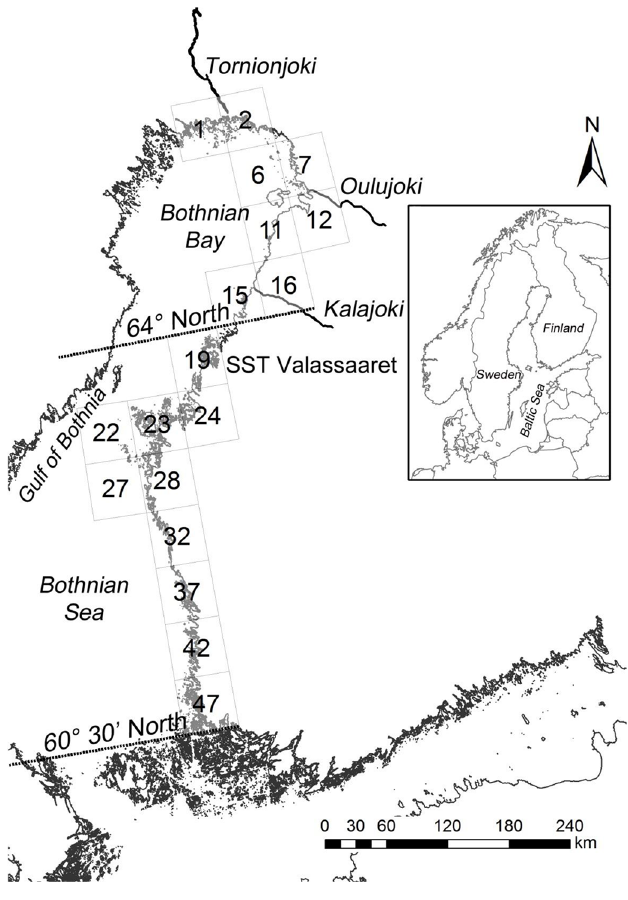
Fig. 1. The northern Gulf of Bothnia, covering ICES rectangles 1 – 16 (between latitudes 66 ° N and 64 ° N), and the southern Gulf of Bothnia, covering ICES rectangles 17 – 47 (between latitudes 64 ° N and 60 ° 30 ’ N). The white fi sh ( Coregonus lavaretus ) samples were collected in the indicated rectangles in 1998 – 2014. Rivers: 1= Tornionjoki, 2= Oulujoki, 3 =Kalajoki. Sea surface temperature measurement site: Valassaaret